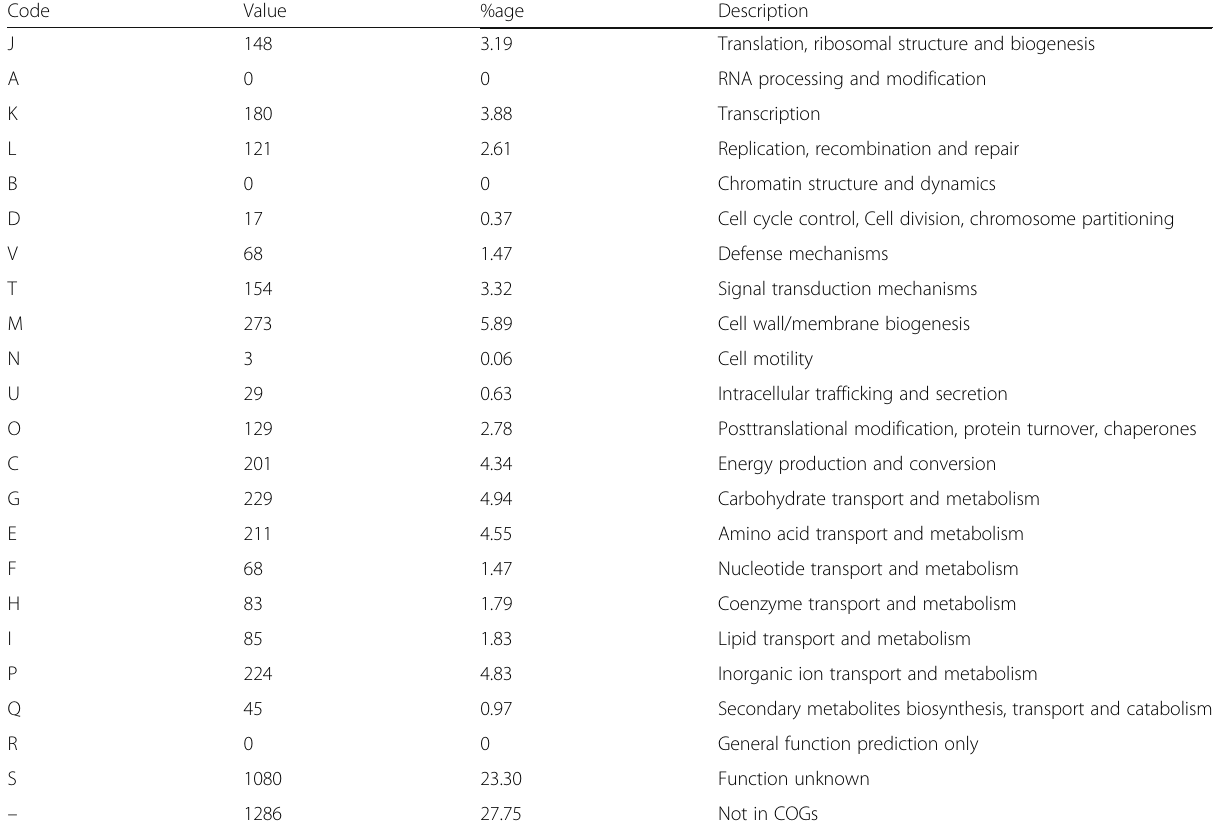
Table 4 Number of genes associated with general COG functional categories Code Value